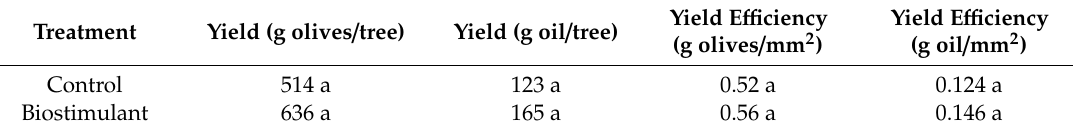
Table 1. Tree yield and yield e ffi ciency of young treated and control trees in the field.